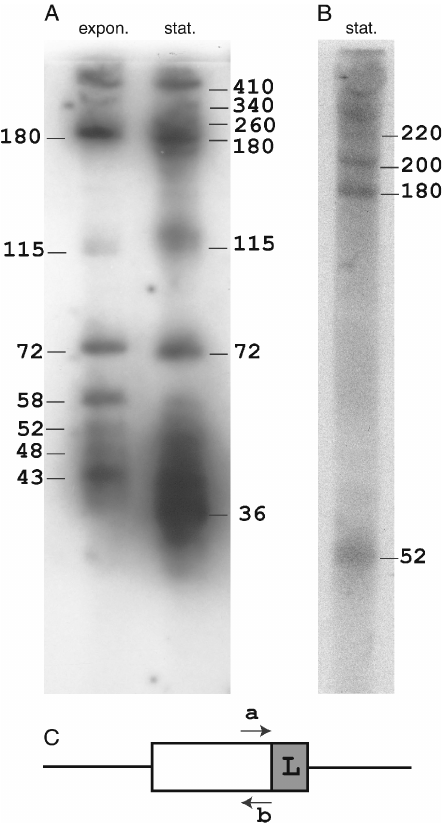
Figure 4. Northern blotting analyses of RNA transcripts obtained from the cluster saci-4 of S. acidocaldarius . (A) Transcripts from one strand were detected in total RNA extracted from cells grown to expo - nential (expon.) or stationary (stat.) phase. (B) Transcripts were ob- served from the complementary DNA strand at stationary phase. The approximate estimated nucleotide lengths of the RNA products are given. The minimal detection limit, using 26-nt. probes, was esti- mated at 15–16 nucleotides. (C) Denotes the location of the primers “a” and “b,” and “L” indicates the location of the putative tran- scriptional leader within the flanking